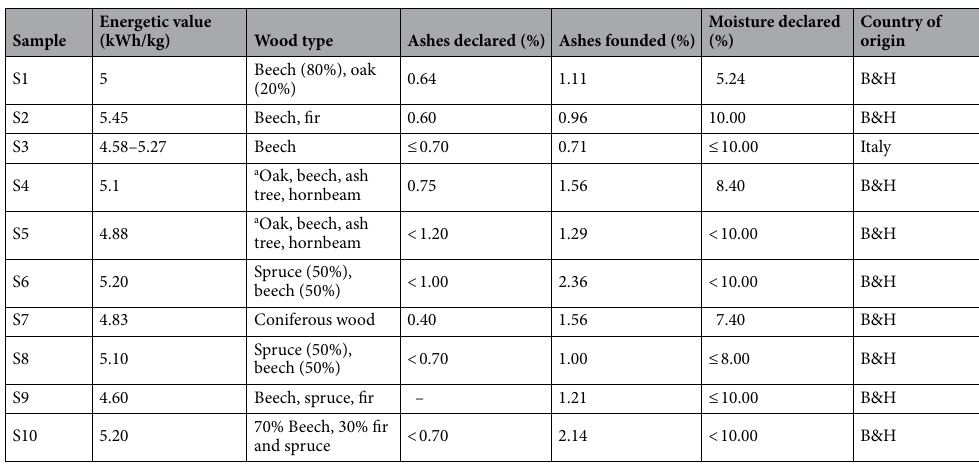
Table 1. Characteristic of analyzed samples wood pellets. a Wood from forest waste, firewood, sawdust, and other wood processing